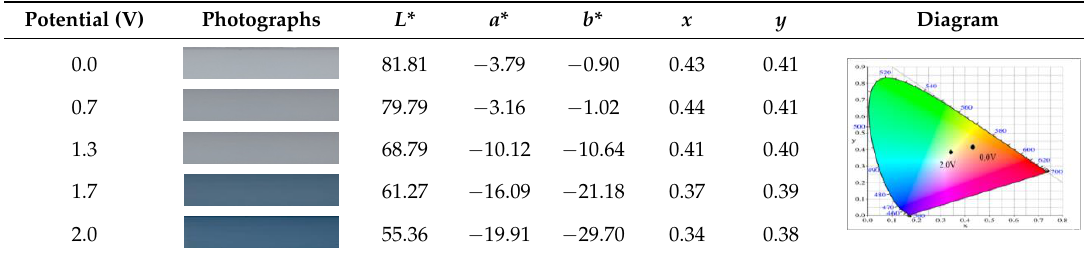
Figure 8 showed the electrochromic switching profiles of PDiCP/PEDOT-PSS, P(DiCP- co - CPDT)/PEDOT-PSS, P(DiCP- co -CPDT2)/PEDOT-PSS, P(DiCP- co -CPDTK)/PEDOT-PSS, and P(DiCP- co -CPDTK2)/PEDOT-PSS ECDs , the transmittance variations of these ECDs were carried out between 0.0 V and 1.8 V with a time interval of 10 s. The Δ T , ΔOD, Q d , η , τ c , and τ b of PDiCP/ PEDOT-PSS , P(DiCP- co -CPDT)/PEDOT-PSS, P(DiCP- co -CPDT2)/PEDOT-PSS, P(DiCP- co -CPDTK)/PEDOT-PSS, and P(DiCP- co -CPDTK2)/PEDOT-PSS ECDs estimated at the second cycle are listed in Table 6.